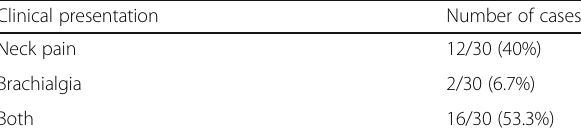
Inclusion criteria Table 1 Distribution of cases according to clinical presentation